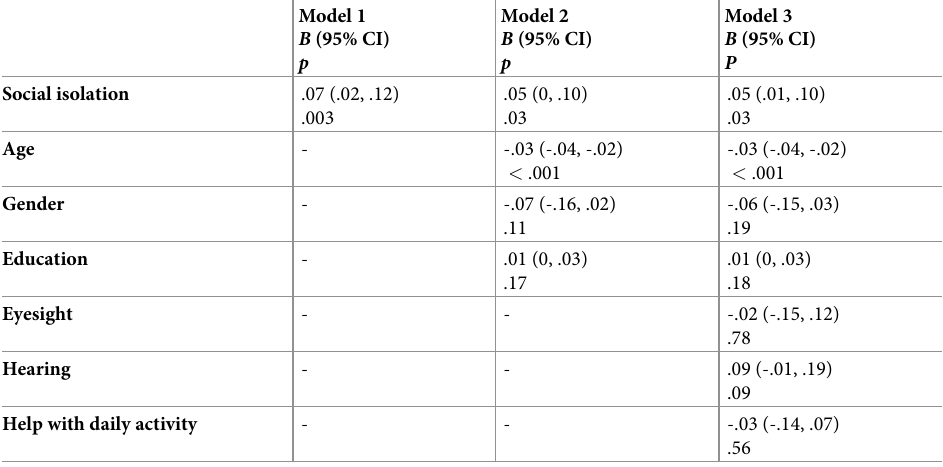
Table 3. Longitudinal association between social isolation and cognitive change